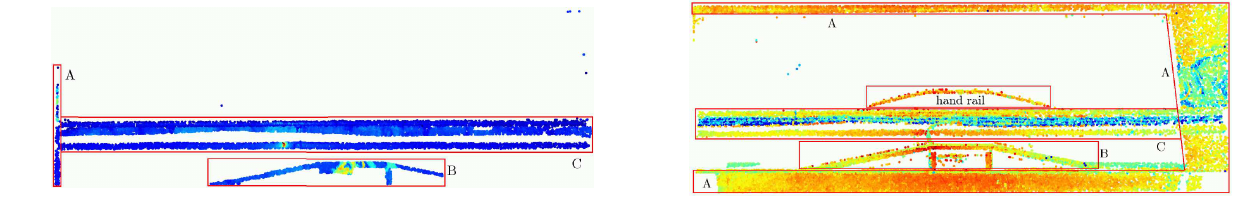
Figure 6: Possible changes Left: Epoch 1. Right Epoch 3.